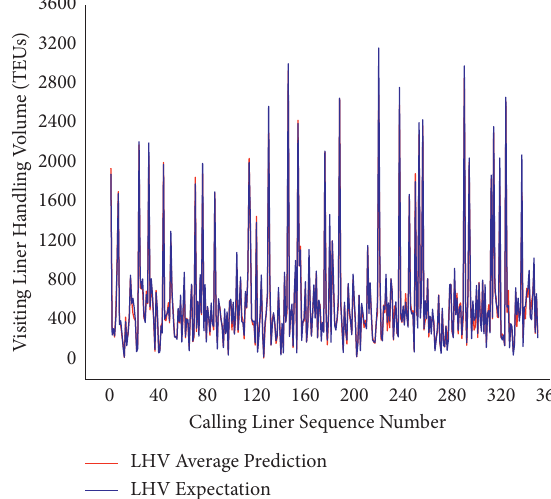
Figure 10: A comparison of LHV prediction average results with real values by